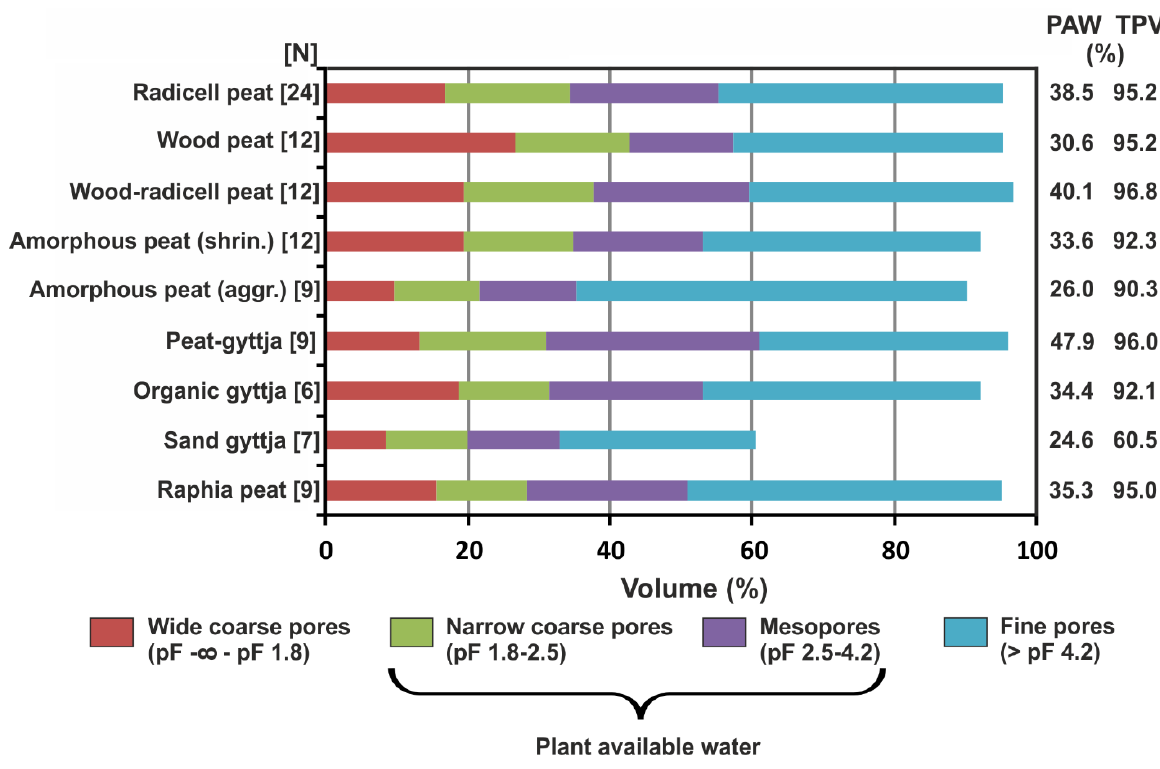
Figure 5. Pore size distribution of each of the substrates. PAW = plant available water; TPV = total pore volume; N = sample